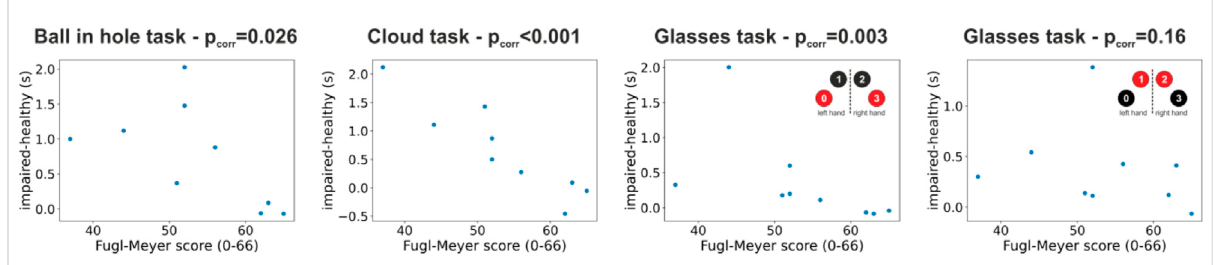
FIGURE 4 Correlation between behavioral results in our VR tasks and Fugl-Meyer clinical scores. The four scatterplots show the difference in completion times between the impaired and healthy limb for each patient and condition plotted against the Fugl-Meyer clinical assessment. Each panel shows results for one task and each dot represents data for one patients. The p -value of the correlation (Spearman ’ s rank-order correlation) between completion times and Fugl-Meyer scores is shown in the panels ’